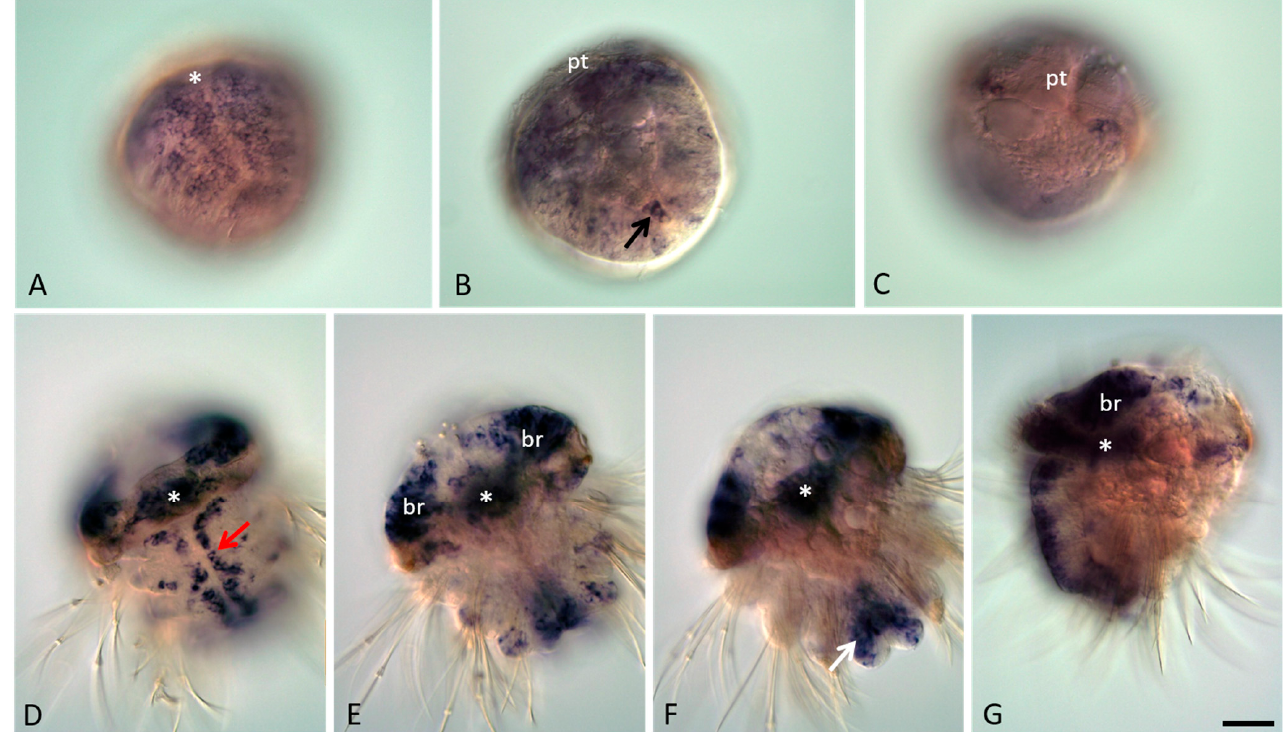
Figure 3. Avi-nanos RNA expression patterns during metatrochophore larva development. Except for ( C , G ), all animals are oriented anterior to the upper left corner. ( A – C ) Early metatrochophore at different focal planes; ( D – G ) Late metatrochophore at different focal planes. ( A ) Avi-nanos is broadly expressed in most cells of the ventral plate, including the forming stomodeum (foregut anlage) and in the presumptive neuroectoderm; ventro-caudal view in a surface focal plane. ( B ) A nanos transcript is observed in the developing chaetal sacs and proctodeum (hindgut anlage), where putative PGCs are located ( arrow ); ventro-caudal view, deeper. ( C ) Dorsal surface view, anterior upward. ( D ) Robust Avi-nanos expression is detected in the stomodeum, ventral nerve system, and putative peripheral neurons; ventral view in a surface focal plane. ( E ) Expression in the brain, stomodeum, and the putative parapodial neurons; ventral view, deeper. ( F ) Expression in the anal lobes and the hindgut ( arrow ). ( G ) A deep lateral view of the late metatrochophore, anterior upward, ventral to the left. white asterisk mark position of stomodaeum: br , brain, pt , prototroch. Scale bar, 40 mkm for all